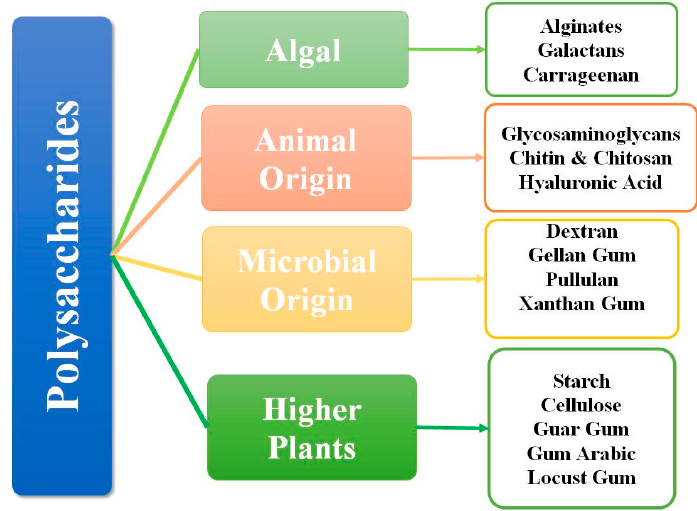
Figure 1. Natural polysaccharides: structural features and properties.